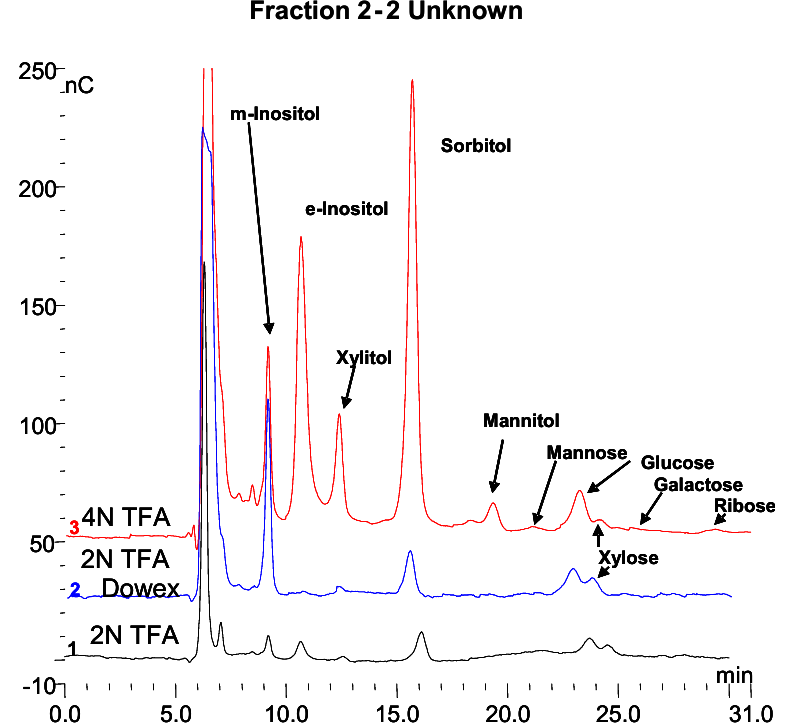
Figure 8. The monosaccharide chromatograms for Fraction 2 (2-2) are shown from bottom to top for 2 N TFA hydrolyzate, Dowex 50 column, and 4 N TFA hydrolyzate.